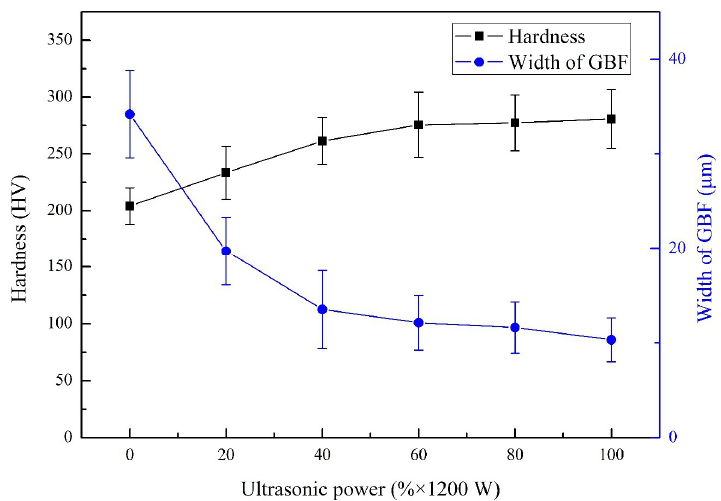
Figure 11. The average hardness of weld metal and width of grain boundary ferrite (GBF) in the deposited metal of joints welded at different ultrasonic output power. Table 2. Mechanical properties of joints.